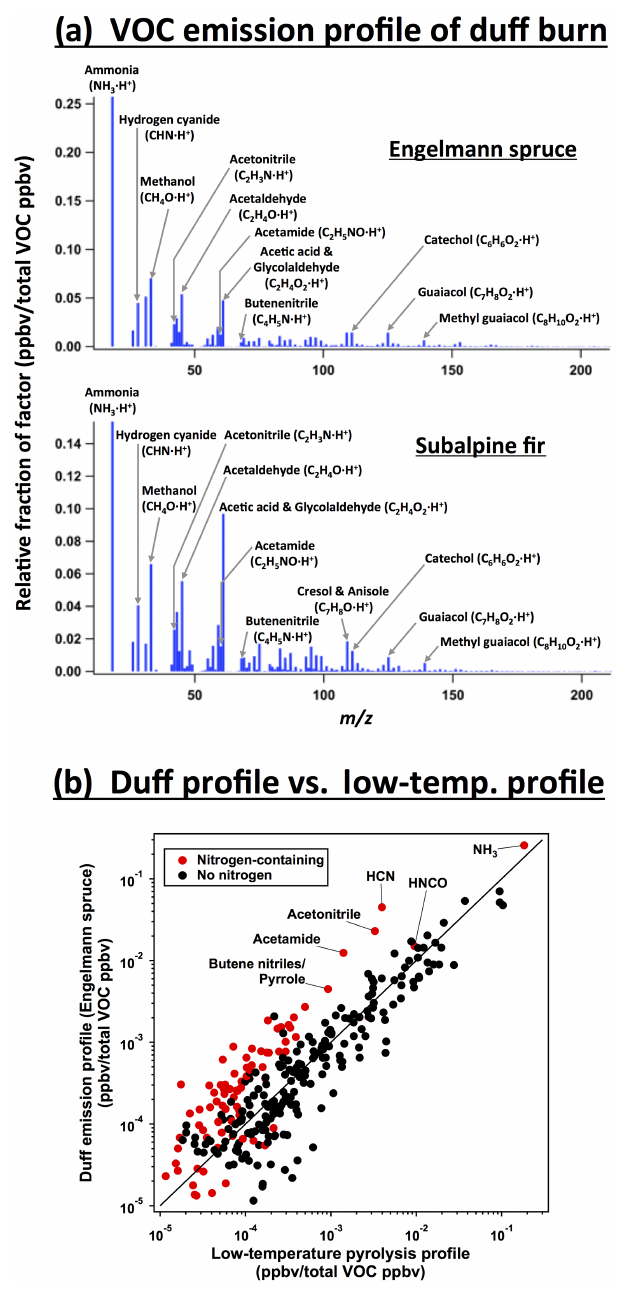
Figure 12. (a) VOC emission profile of duff burn of Engelmann spruce and subalpine fir. (b) Scatter plot of duff emission profile (Engelmann spruce) versus average low-temperature pyrolysis pro-